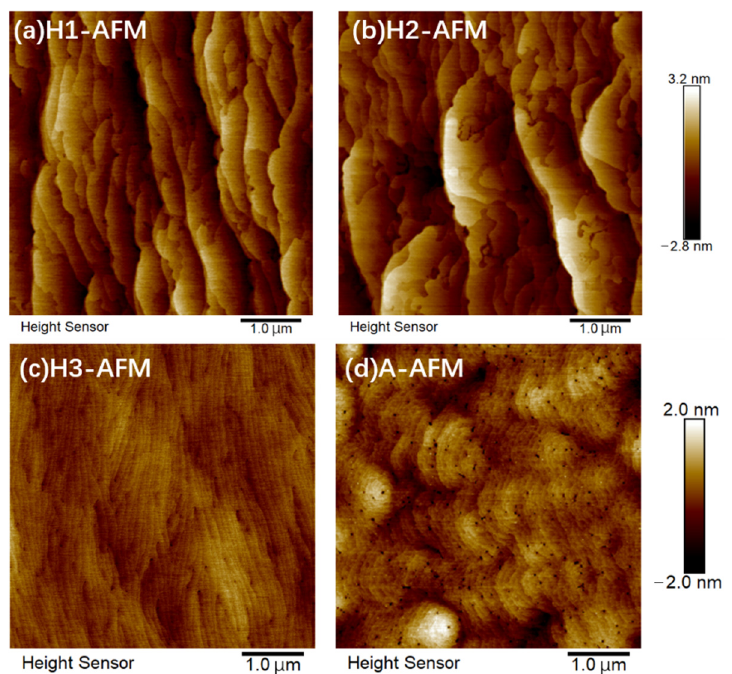
Figure 8. Surface morphology measured by atomic force microscope in tapping mode for samples H1 ( a ), H2 ( b ), H3 ( c ), and reference sample A ( d ).